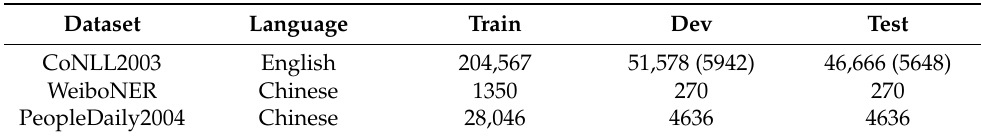
Table 1. NER dataset.